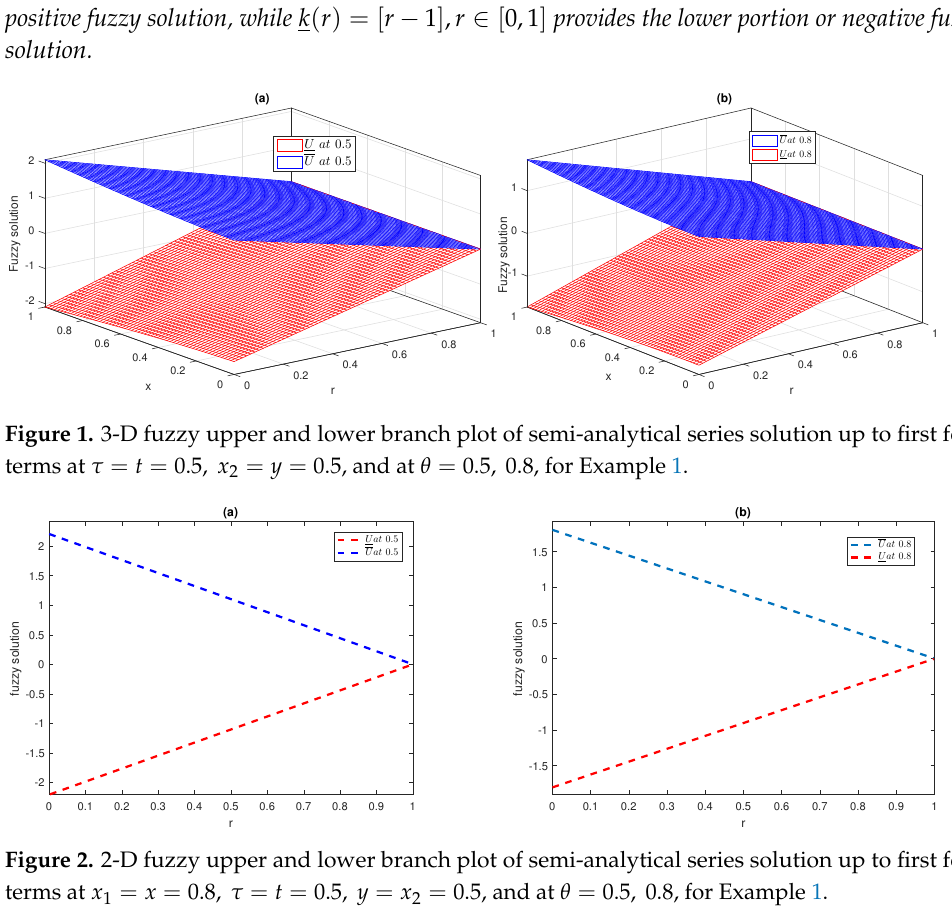
Figure 2. 2-D fuzzy upper and lower branch plot of semi-analytical series solution up to first four terms at x 1 = x = 0.8, τ = t = 0.5, y = x 2 = 0.5, and at θ = 0.5, 0.8, for Example